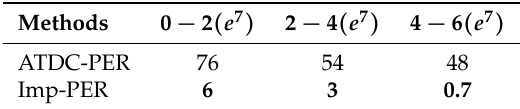
Table 3. The MAPE of each method on game Pong. Each cell represents the mean value of the corresponding period. Bold font shows the best